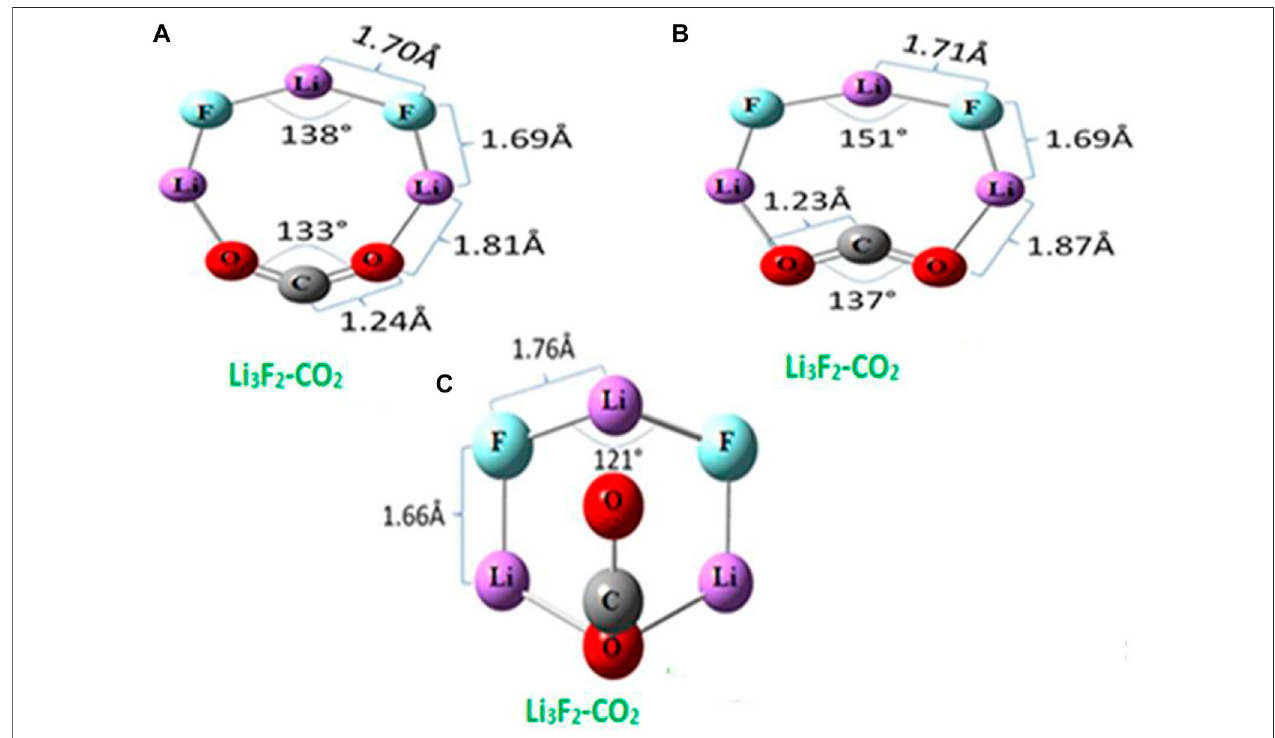
FIGURE4| EquilibriumstructuresofCO 2 complexwithbinuclear superalkaliwithbondlengthsfrom Ref. 41withthepermissionoftheRoyalSocietyofChemistry.